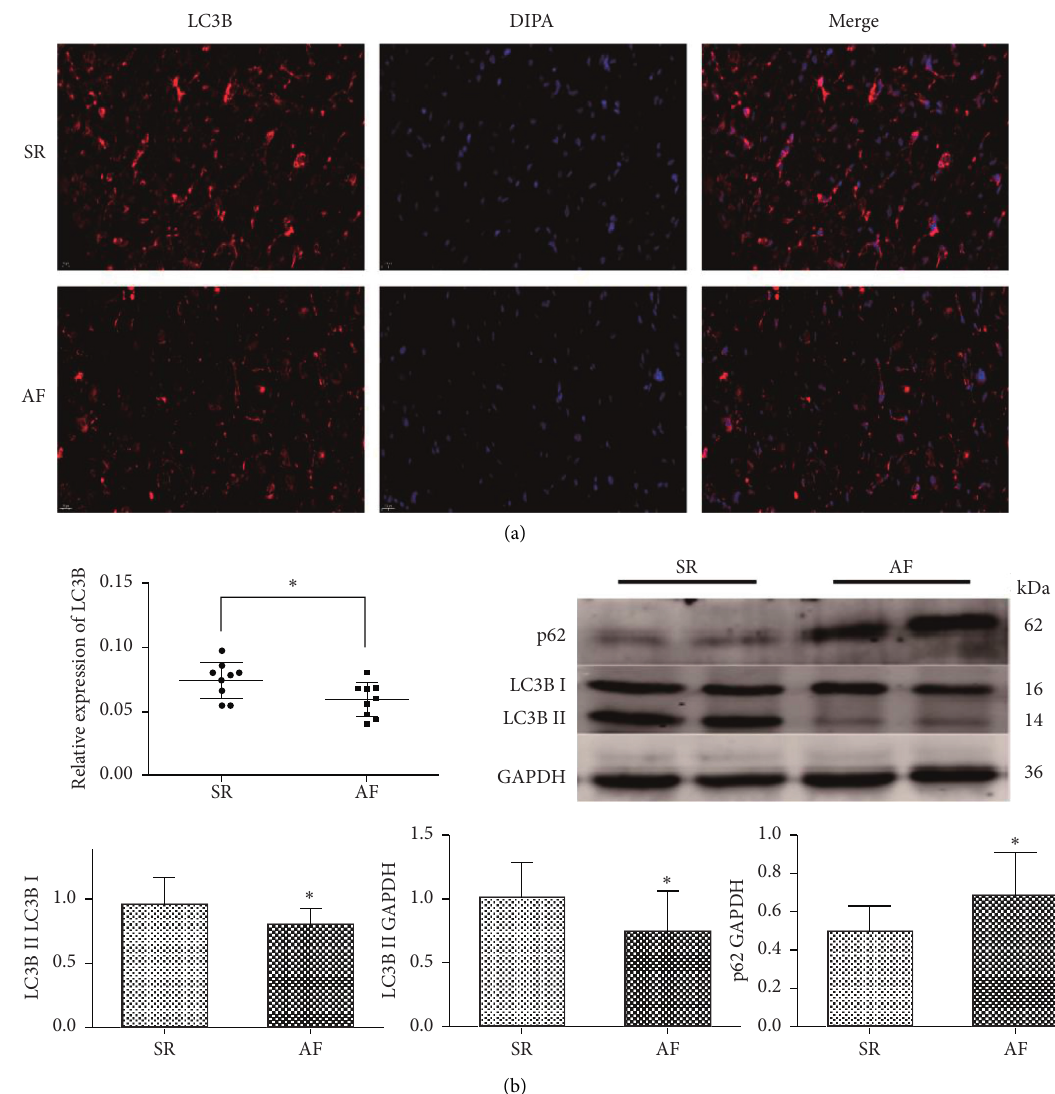
Figure 1: Impaired cardiac autophagy in patients with chronic AF. (a) Representative immunofluorescence images and semiquantitative analysis of LC3B in RAA ( n � 9 per group). (b) Representative western blots and quantification of protein expressions of LC3B and p62 in RAA (the SR group, n � 16; the AF group, n � 18). Scale bar � 20 μ m. ∗ p < 0.05 vs the SR group. SR, sinus rhythm; AF, atrial fibrillation; RAA, right atrial